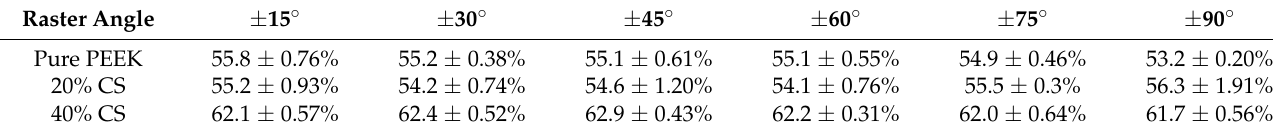
Table 1. The porosity of three scaffolds with different raster